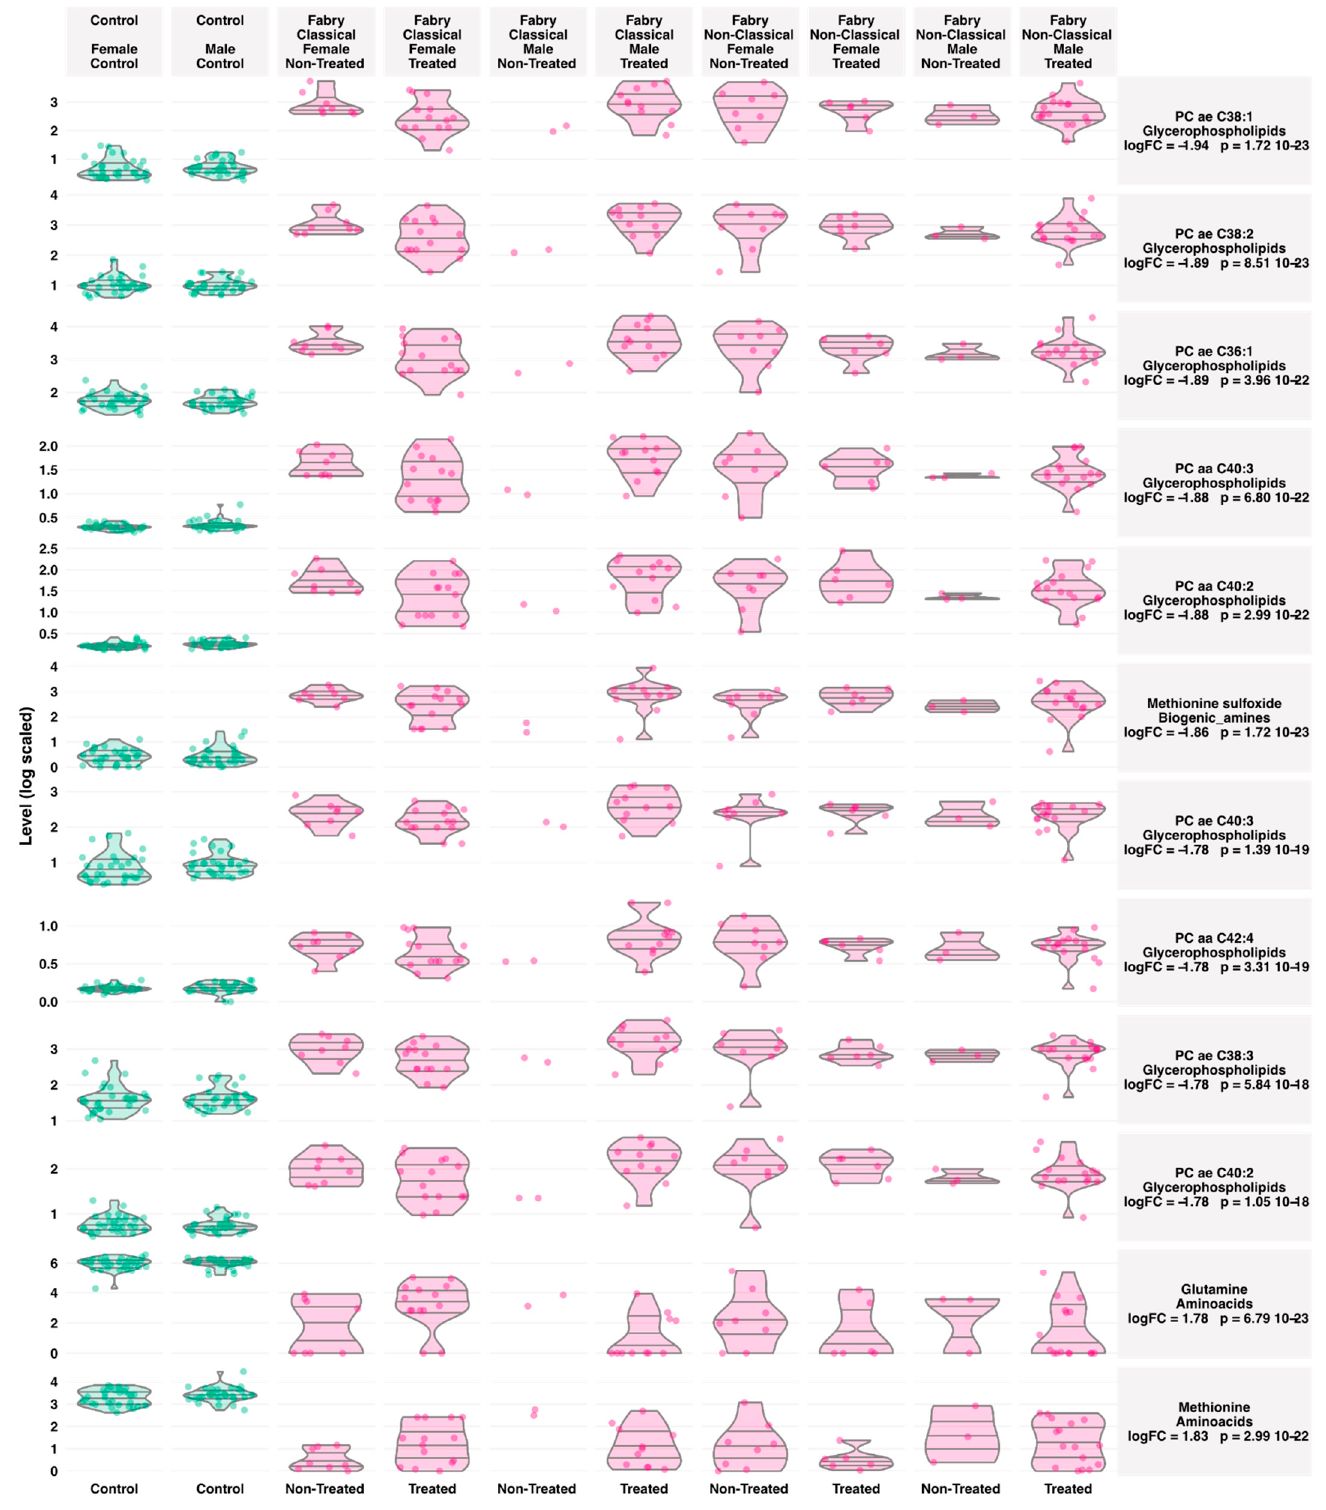
Figure 4. Boxplots of the top varying metabolites between Fabry and control samples. Lines in the violin plots refer to quantiles (0.25, 050 and 0.75).